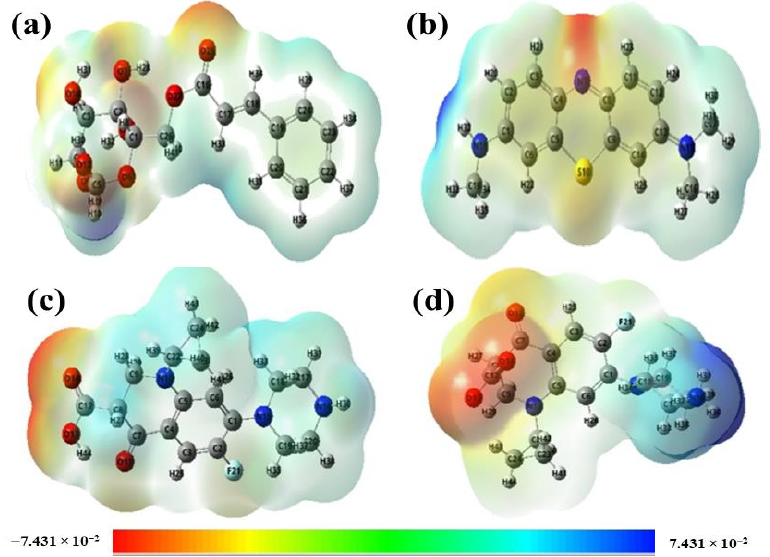
Figure 8. MEP of cellulose cinnamate ( a ), MEP of MB ( b ), MEP of CIP in neutral form ( c ), and MEP diagram of CIP in zwitterion form ( d ).